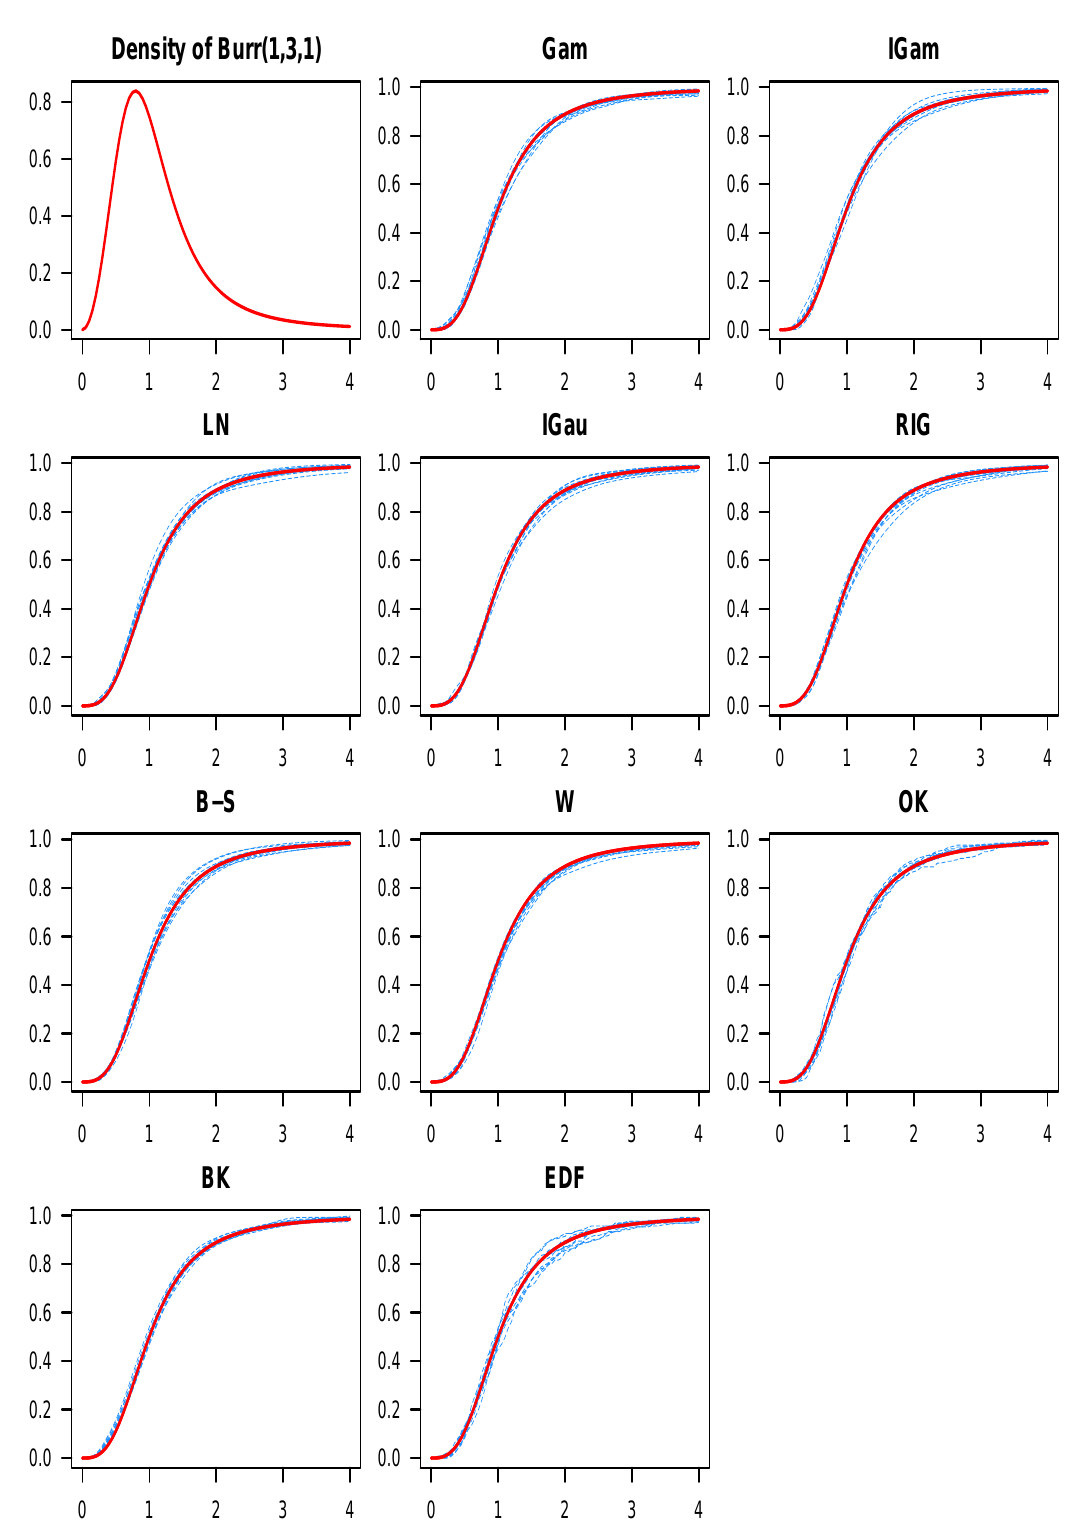
Figure 2. The Burr ( 1,3,1 ) density function appears on the top-left, and the target c.d.f. is depicted in red everywhere else. Each plot has ten estimates in blue for the Burr ( 1,3,1 ) c.d.f. using one of the ten estimators (the name of the corresponding kernel is indicated above each graph) and n =